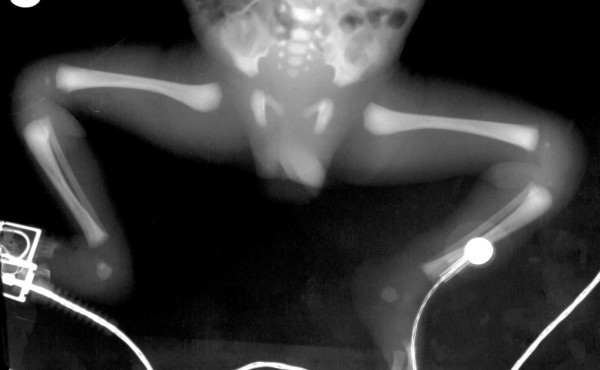
Radiological examination for bone showing epiphysis at the lower end of femur and upper end of tibia in Twin B.